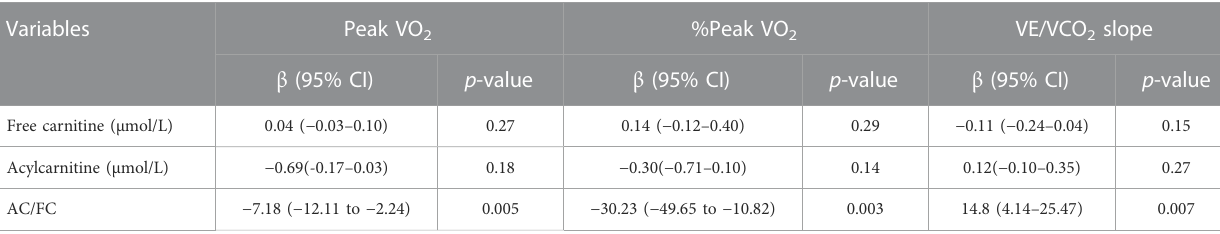
TABLE 4 Simple linear regression analysis to determine the association of clinical parameters with primary